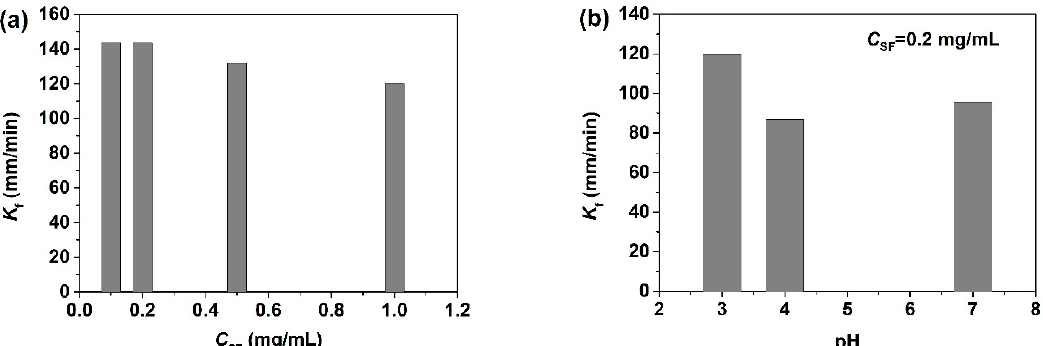
Figure 7. Change of the foaming rate of SF solutions under different solution conditions: ( a ) the influence of C SF , ( b ) the influence of pH (taken from [34,35]).